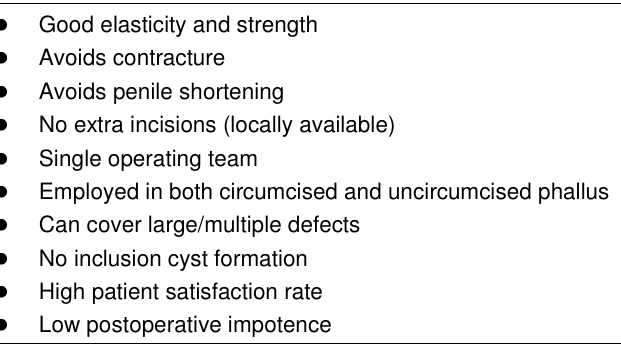
Advantages of Penile Dermal Flap in PD Reconstructive